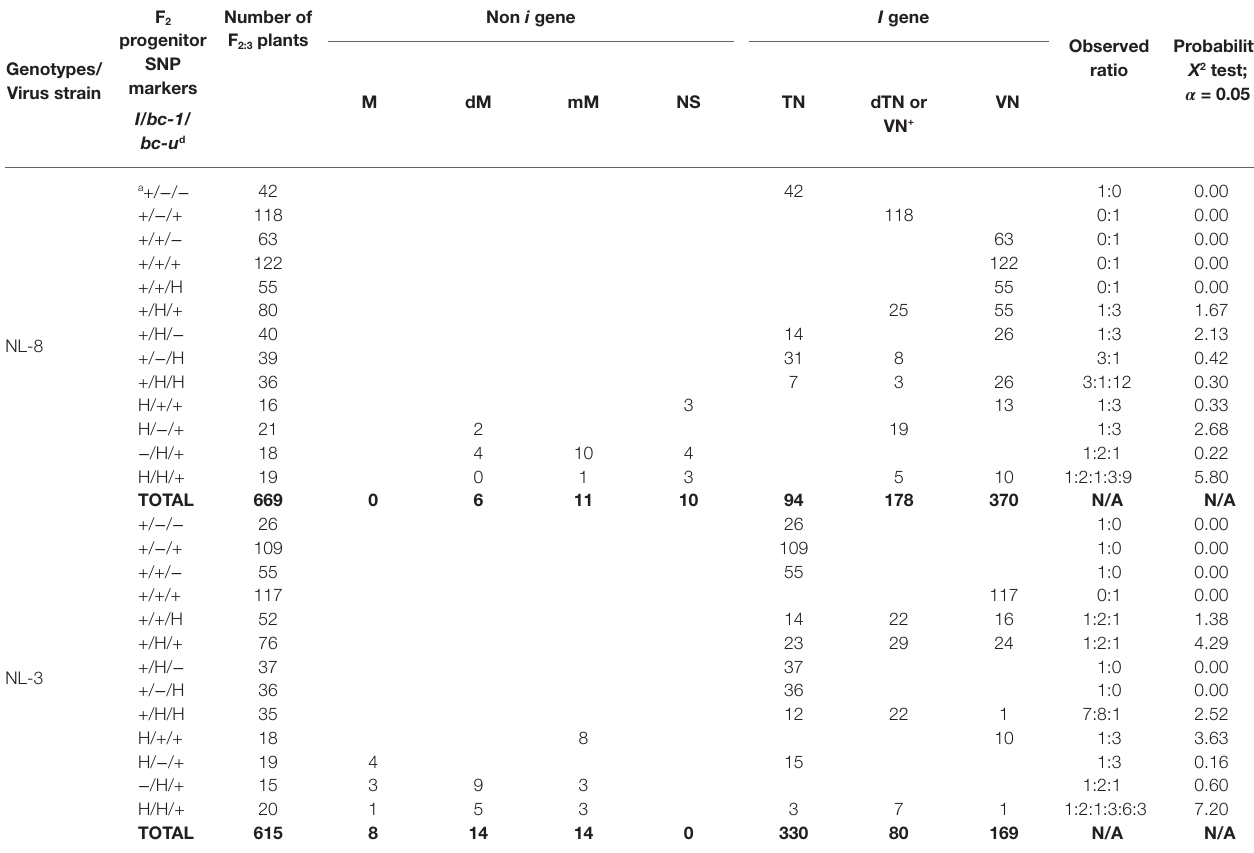
TABLE 6 | Phenotypic reactions to BCMNV NL-8 and NL-3 strains, pooled across F 2:3 families from multiple crosses with the same F 2 genotype based on SNP genetic markers linked with I (S02_48908259), bc-1 (S03_4203361), and bc-u d (Pvbzip1_A_C) genes. F 2 Genotypes/ Virus strain